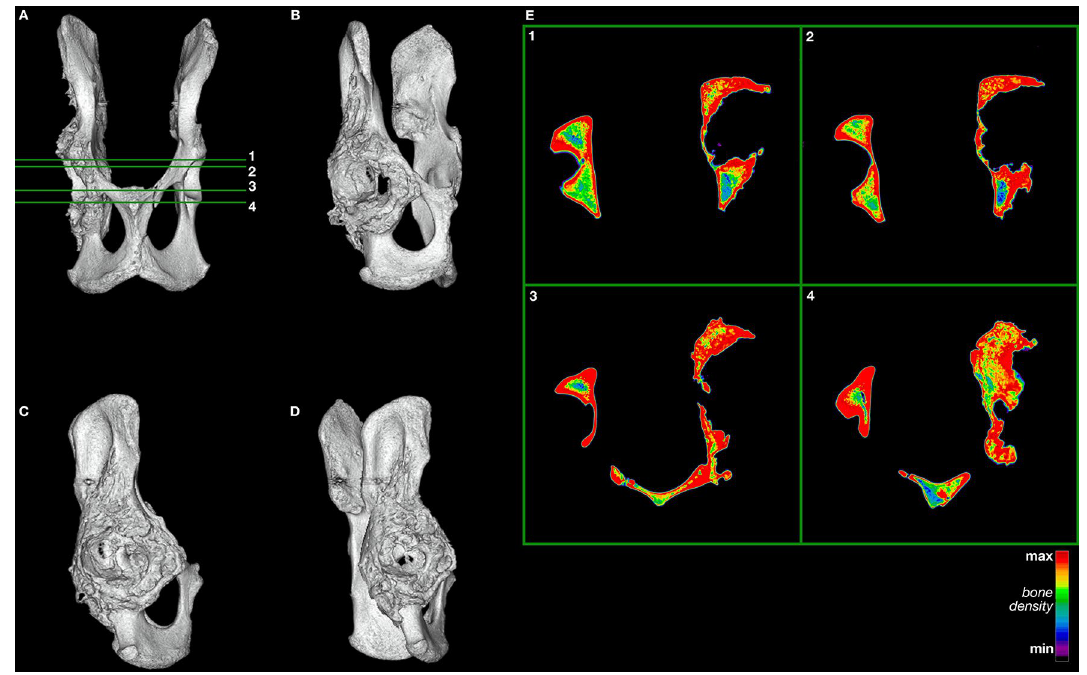
Figure 3. Three-dimensional model of the pathological Smilodon pelvis and acetabulum (LACMHC 131). Horizontal numbered lines in ( A ) mark anatomical location of numbered CT slices displayed in ( E ). ( A ) Ventral view of pelvis, anterior toward top of image; ( B ) rotated 45 degrees from ventral about the anteroposterior axis; ( C ) rotated 90 degrees from ventral about the anteroposterior axis; ( D ) rotated 135 degrees from ventral about the anteroposterior axis. ( E ) 0.63 mm axial CT images of the pathological pelvis demonstrating a dysplastic right hip socket, corresponding with the three-dimensional model, posterior view. Model created using Mimics version 20.0 (https:// www. mater ialise. com/ en/ medic al/ mimics- innov ation- suite/ mimics).